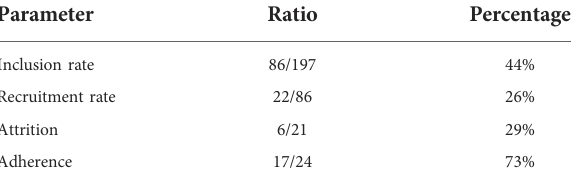
TABLE 2 Feasibility parameters inclusion- and recruitment rate, attrition and adherence.